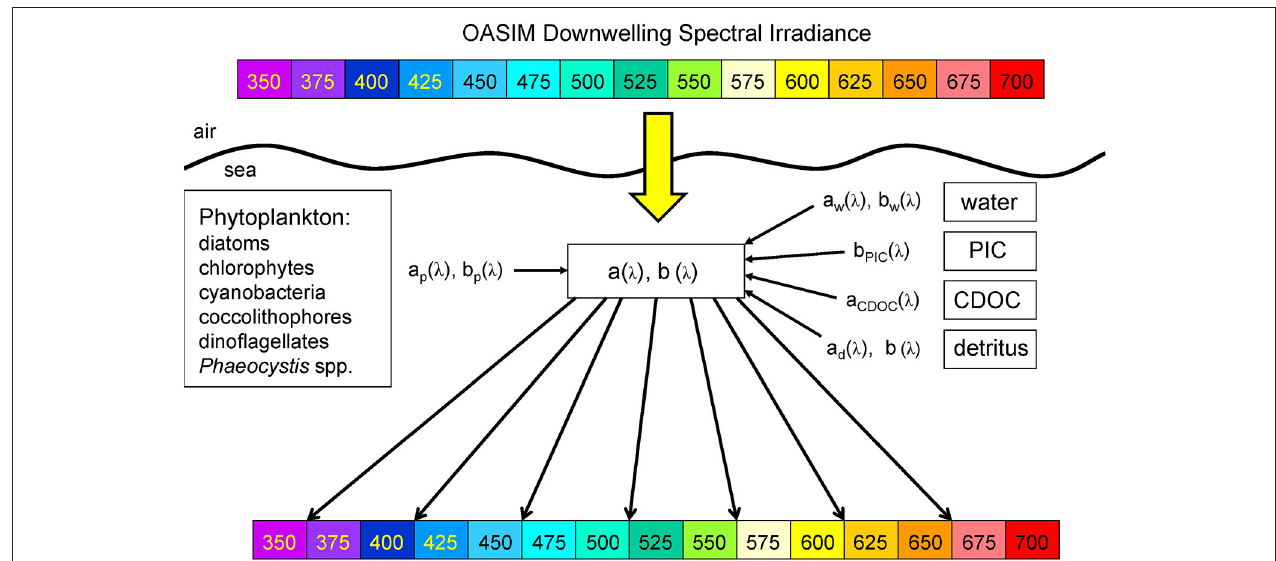
FIGURE 2 | OASIM spectral downwelling radiance and dependencies in the ocean. Shown are the visible bands. Inherent optical properties (spectral absorption coefficient a[ λ ], and spectral scattering coefficient b[ λ ]) are derived from spectral characteristics of water, phytoplankton groups, detritus, PIC, and CDOC. OASIM tracks spectral irradiance from the sun through the atmosphere into and through the